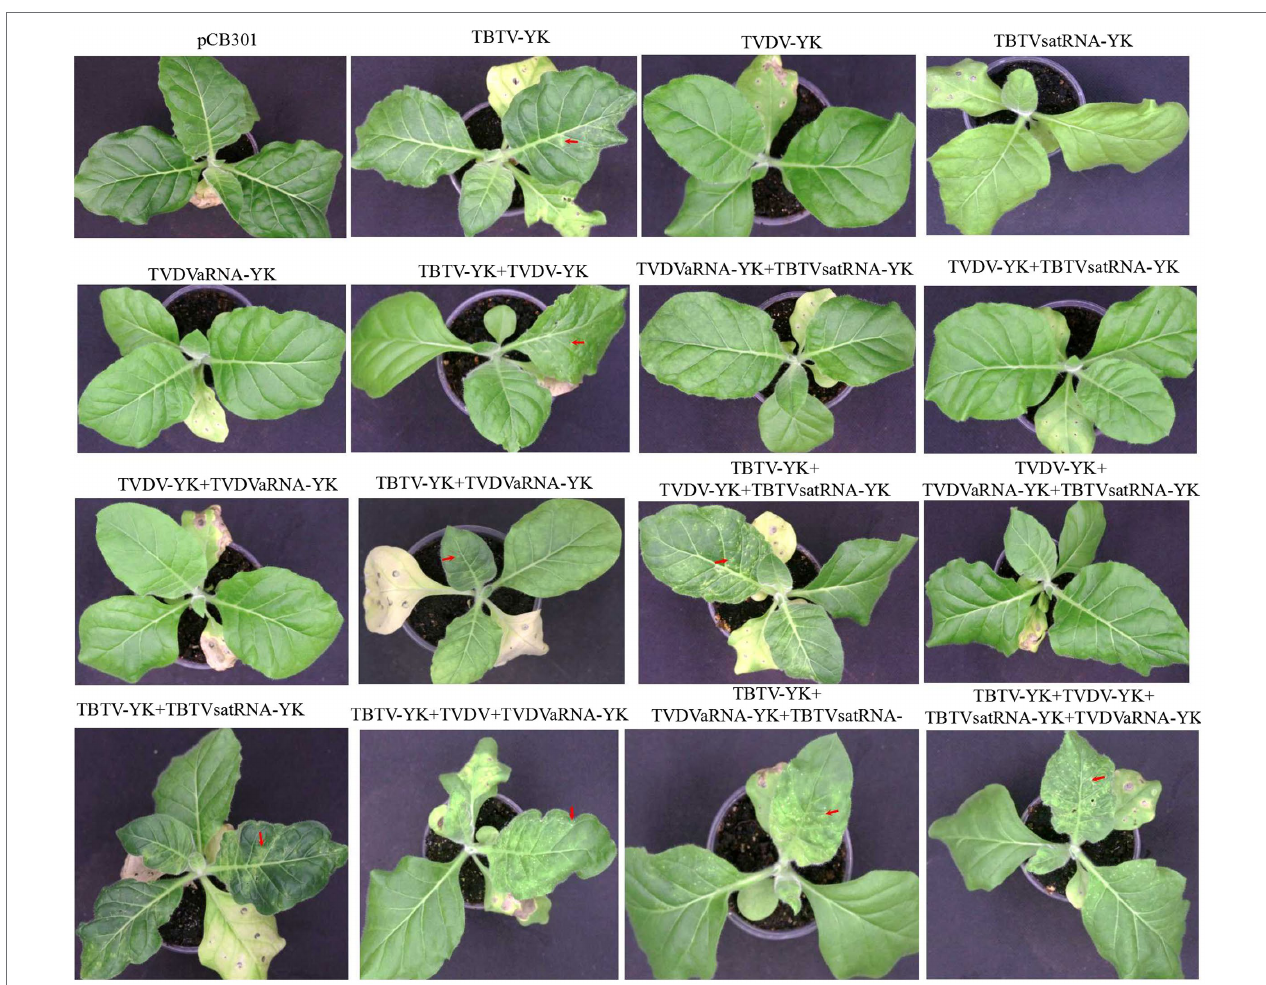
FIGURE 3 | Symptoms on the tobacco K326 plants inoculated with TBTV-YK, TVDV-YK, TBTVsatRNA-YK, and TVDVaRNA-YK, singly or in various combinations, through agro-infiltration. Arrows indicate necrotic spots in the systemic leaves. The plants were photographed at 14 days postinoculation. The plant agro-infiltrated with pCB301 (an empty expression vector) was used as a